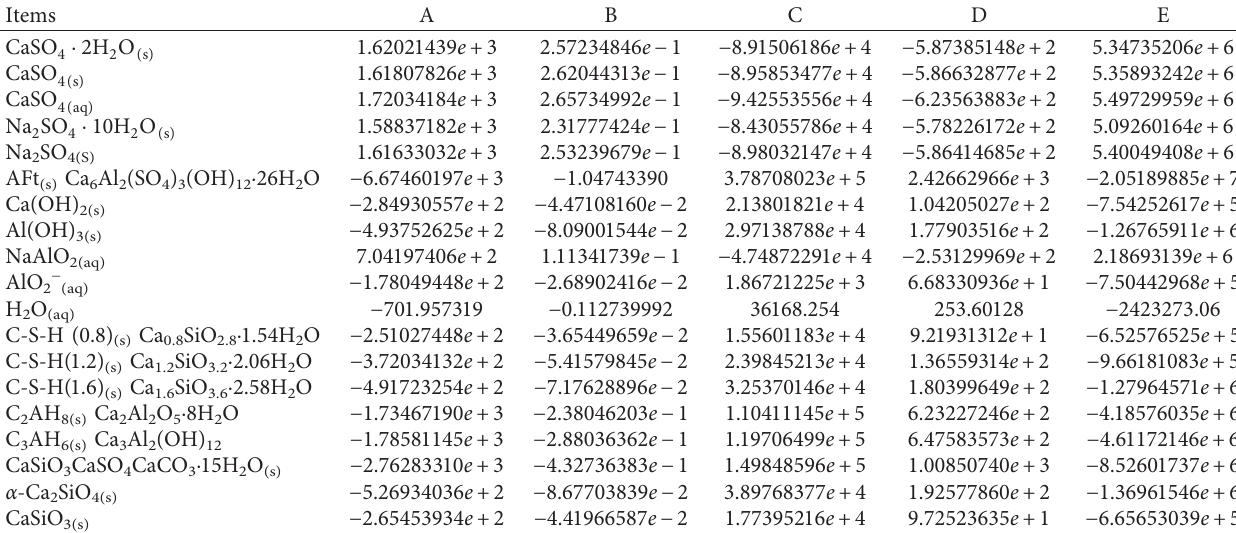
Table 1: Thermodynamic parameters of different substances.